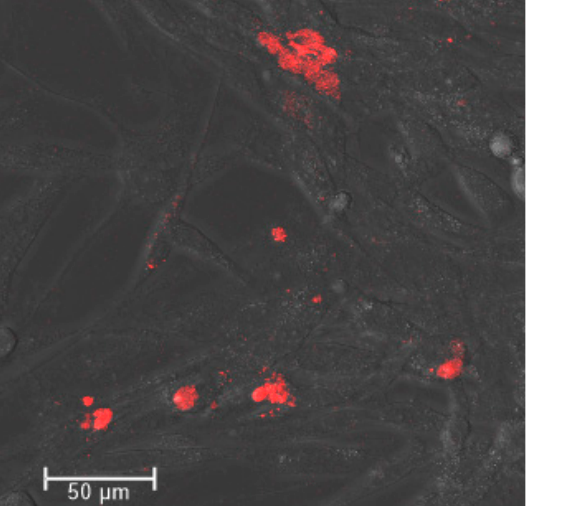
Figure 6. Absorbance and emission (relative to the maximum detected output) spectra of the AuNP suspension.